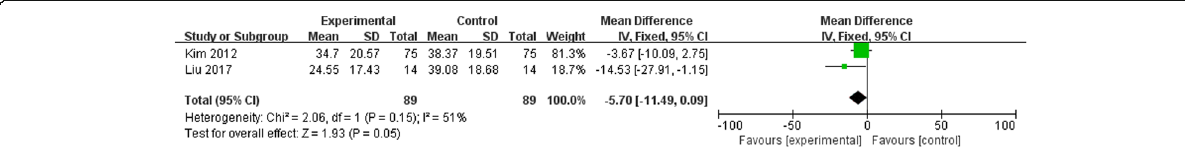
Fig. 5 Ocular surface disease index (OSDI) comparison between acupuncture and artificial tears (AT): Fixed model